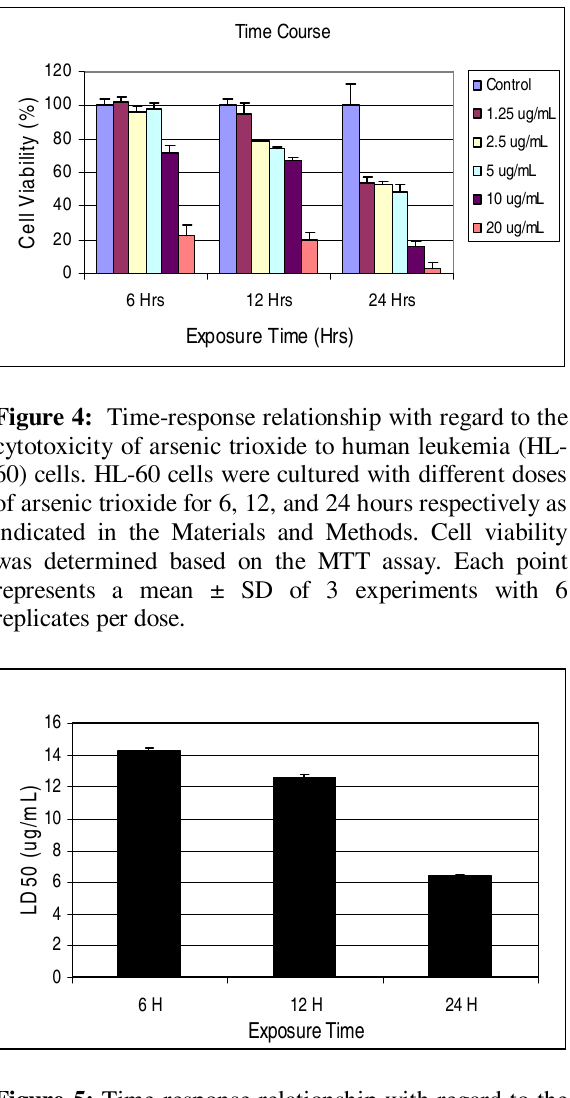
Figure 5: Time-response relationship with regard to the values of arsenic trioxide to human leukemia (HL- LD 50 = 14.26 ± 0.5 µg/mL for 6 h; 12.54 ± 0.3 60) cells. LD 50 µg/mL for 12 h; and 6.35 ± 0.6 µg/mL for 24 h of